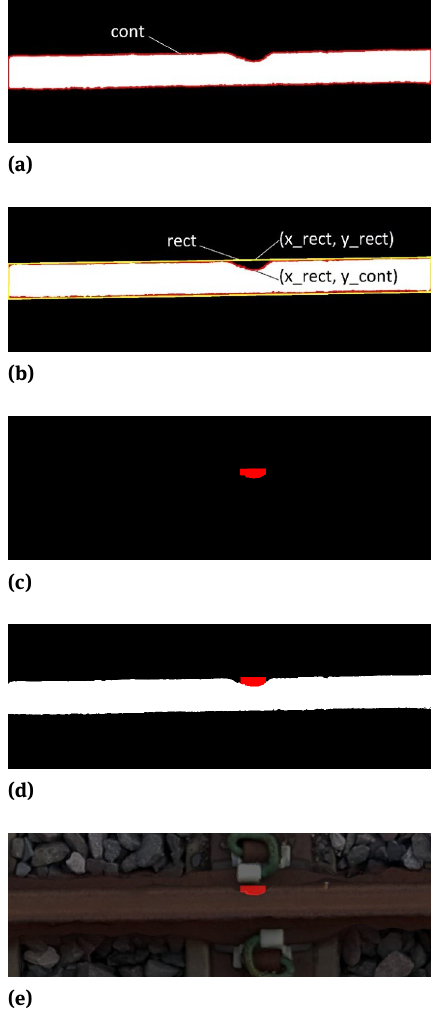
Figure 7: Illustration of consecutive stages of the defect detection al- gorithm described by the pseudocode: a) line 1 of the pesudocode, b) line 2, c) lines 3, 4 and 5, d) defect applied in the rail head area generated by FCN-8, e) defect applied in the track image.